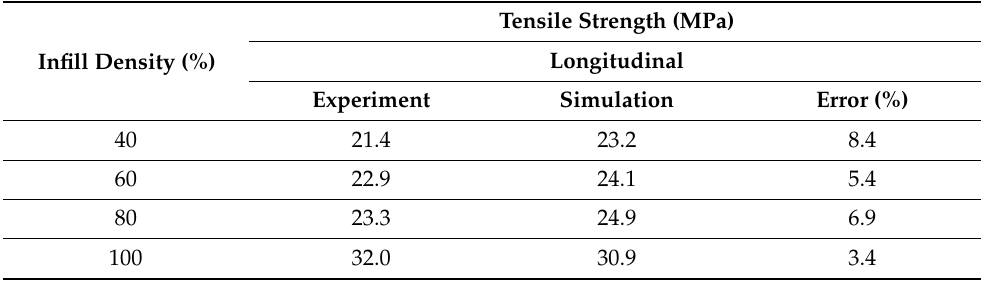
Figure 7. Infill density of 80% at longitudinal orientation: ( a ) equivalent von-Mises stress; ( b ) equivalent elastic strain; and ( c ) 1st failure index. Table 5. Modelling results for the infill density set (Method 1).